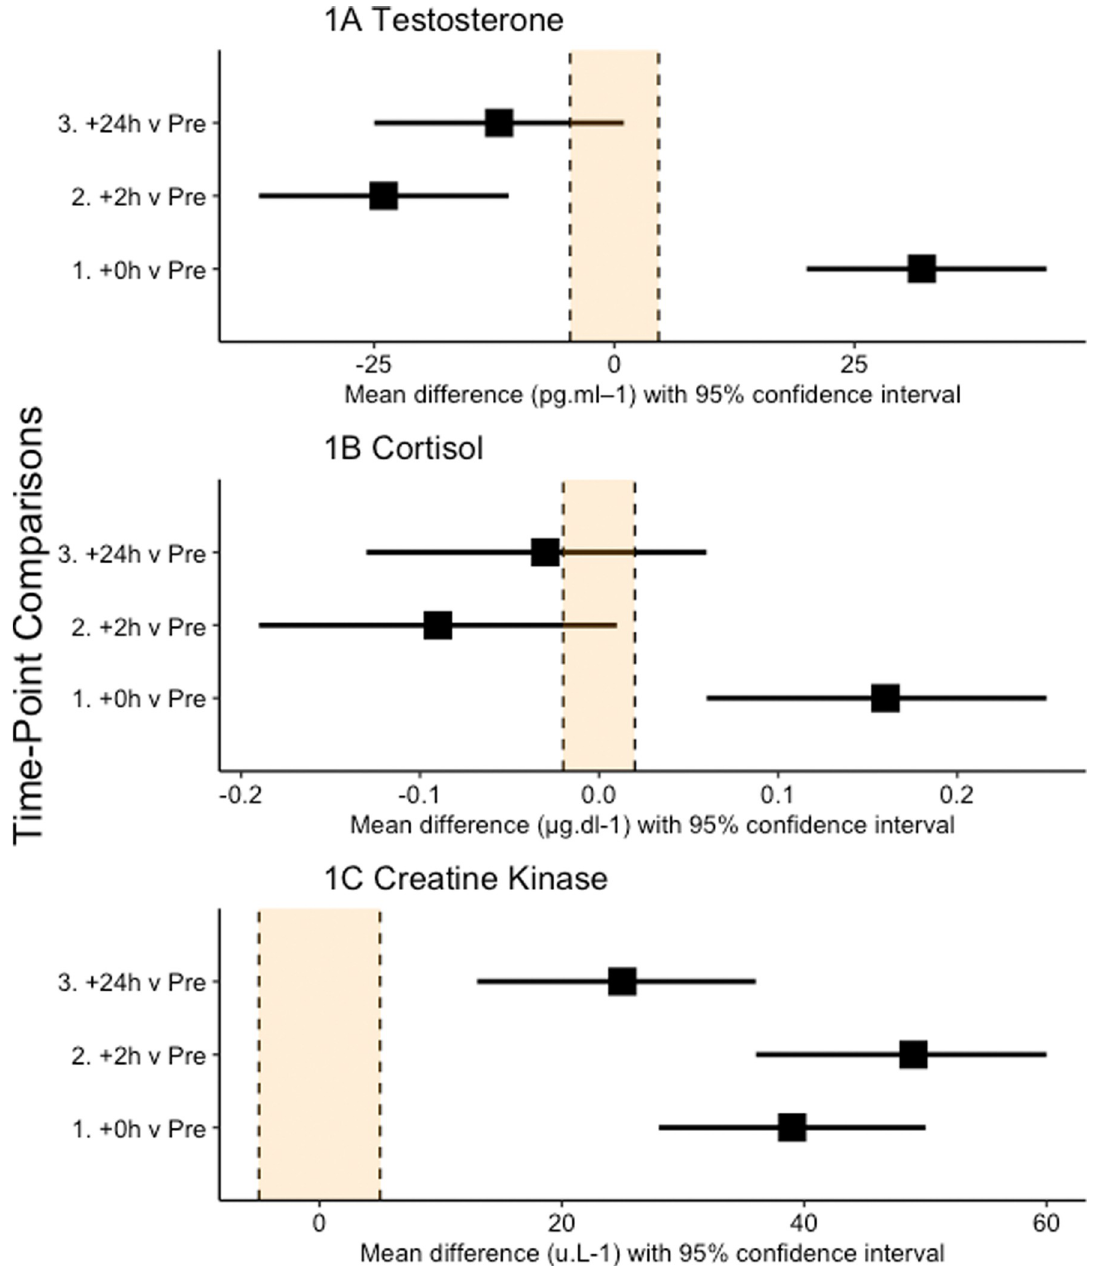
Fig 1. Effect statistics (mean difference and 95% confidence intervals) for the comparison of testosterone (A), cortisol (B) and creatine kinase (C) concentrations immediately (+0h), two (+2h) and 24 (+24h) hours following the performance of the training session compared to baseline. Zero (0) on the axis represents no difference between that time-point and